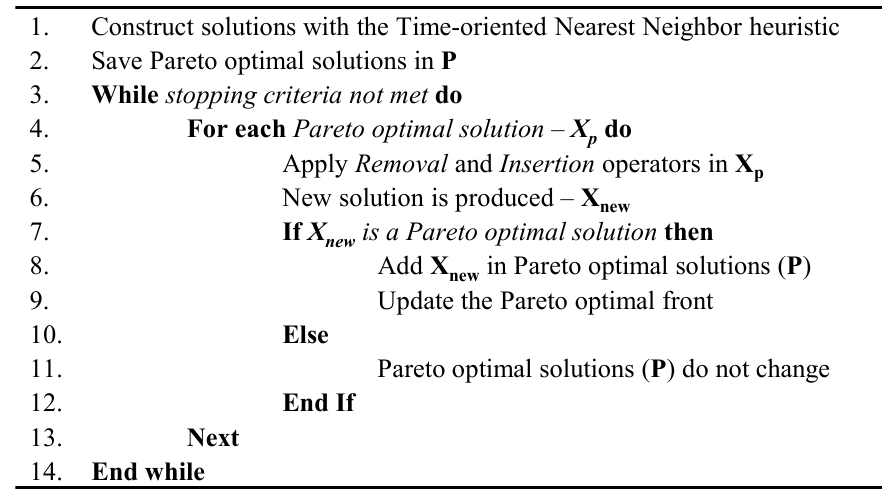
Figure 4. The general framework of the MOLNS.